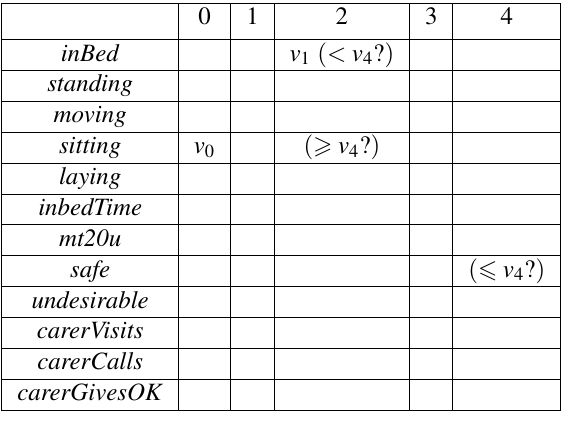
Table 8. The Searching Process of